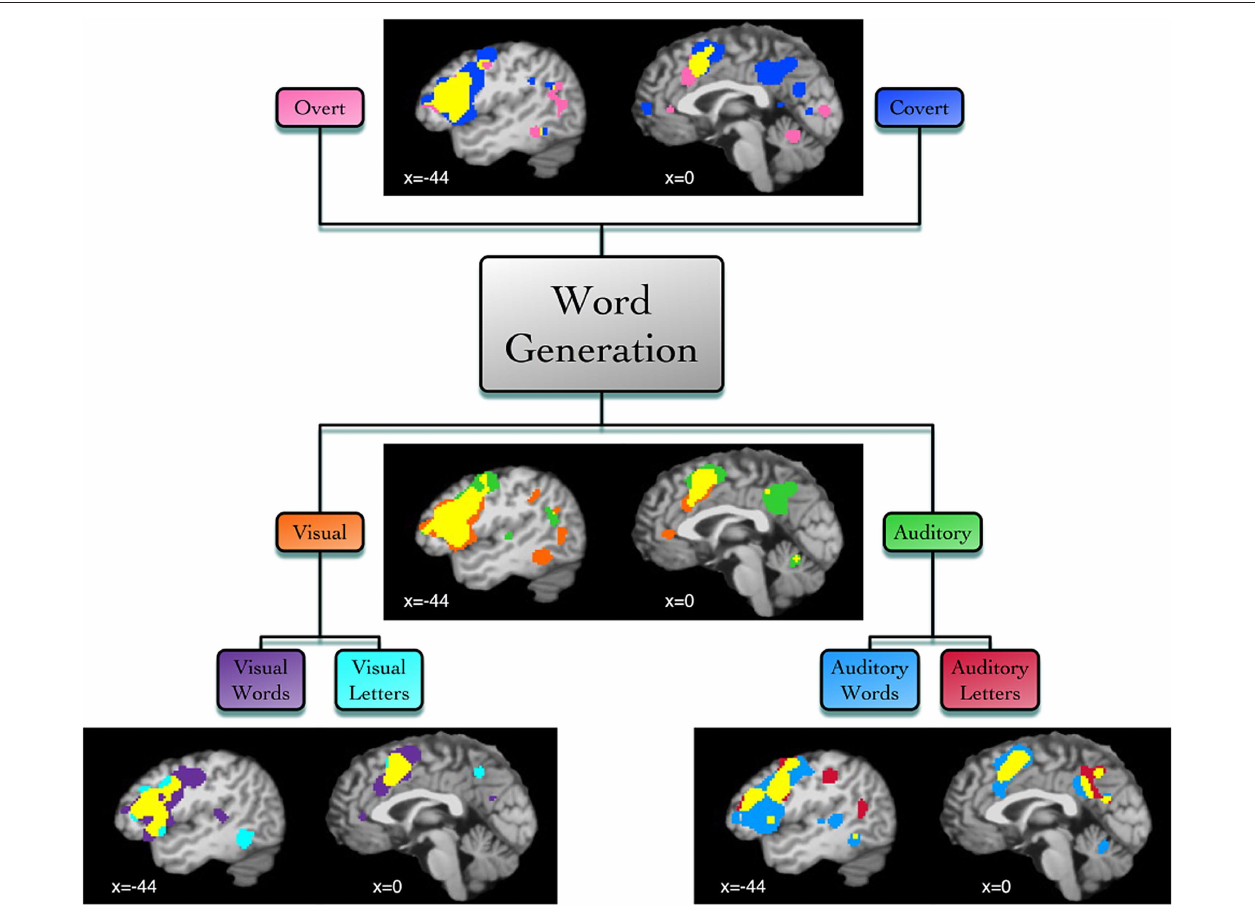
86 experiments, 621 coordinates), visual words (25 papers, 88 experiments, 638 coordinates), visual letters (14 papers, 38 experiments, 373 coordinates), auditory words (39 papers, 124 experiments, 1001 coordinates), and auditory letters (14 papers, 35 experiments, 279 coordinates). Results are displayed at P < 0.05, corrected. Left lateral ( x = − 44) and medial ( x = 0) sagittal slices display the comparative meta-analytic results. In all images, the overlap between meta- analysis results is shown in